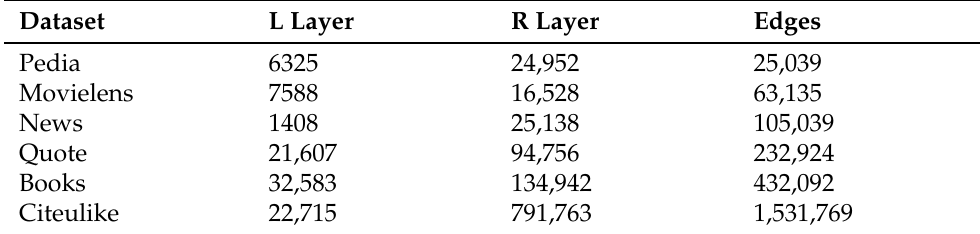
Table 2. Statistics of datasets.